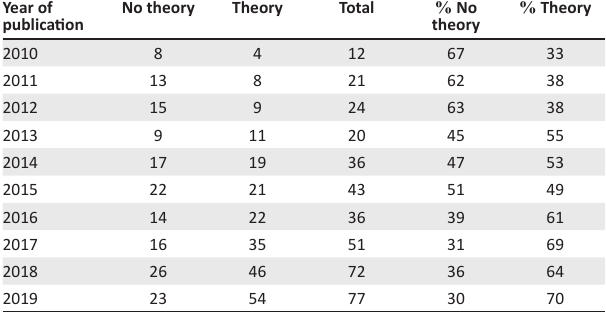
TABLE 4: Sustainability reporting papers with and without theories in each